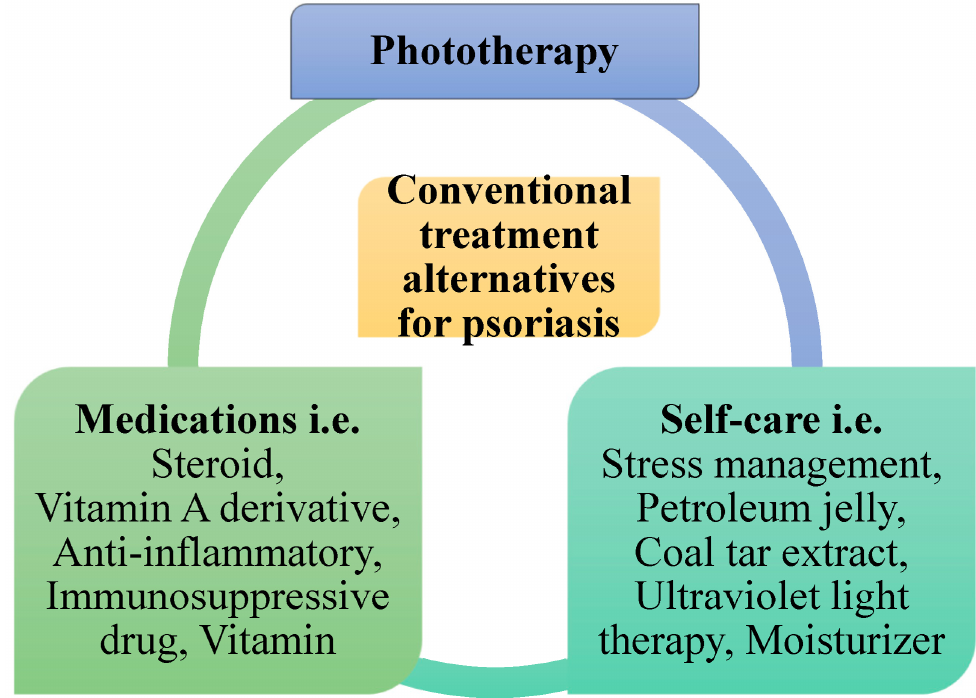
Figure 2. Conventional treatment alternatives for psoriasis